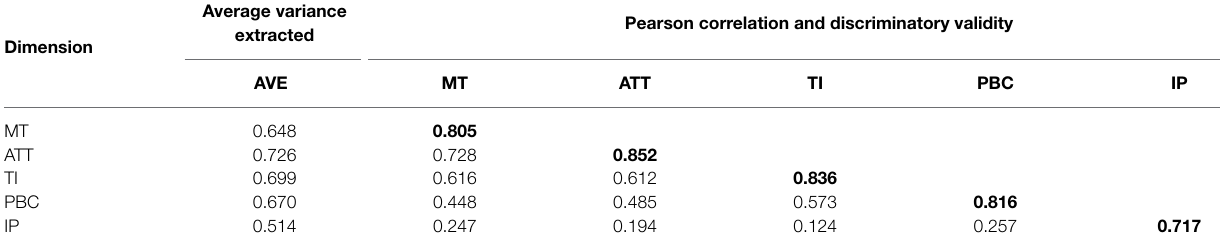
Pearson correlation and discriminatory validity